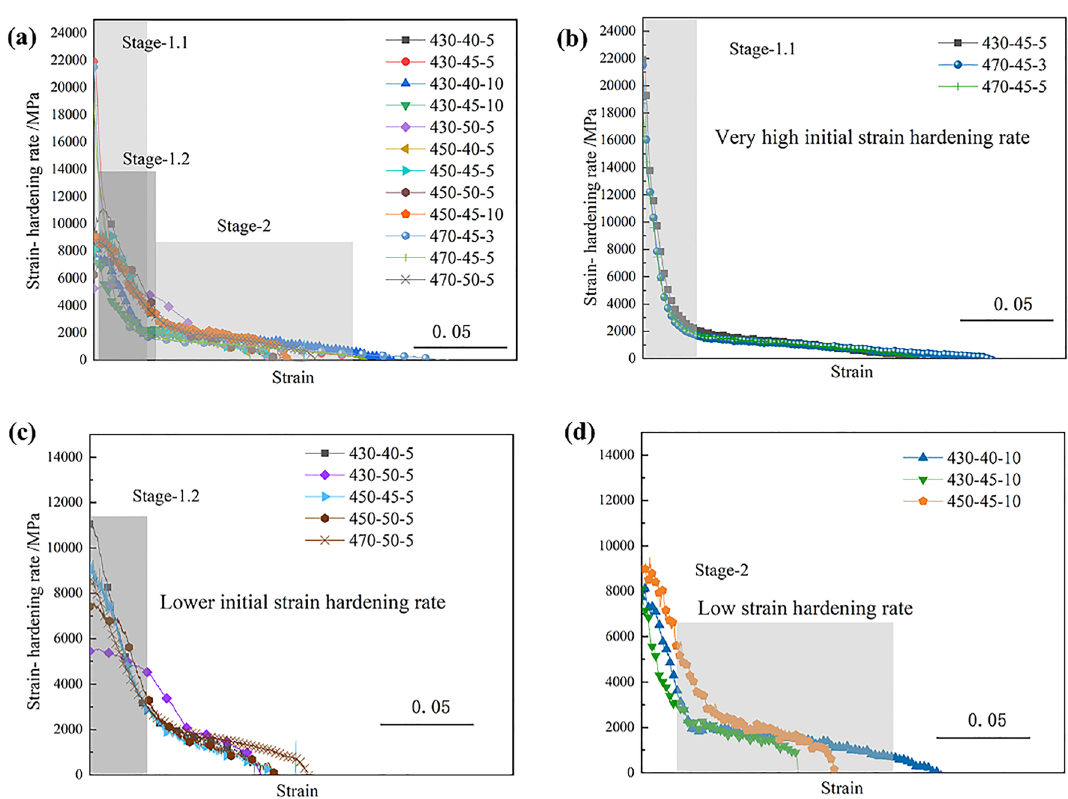
Figure 10. Strain hardening rate vs. true strain at different sintering processes: ( a) all strain hardening rate curves; ( b) the first kind; ( c) the second kind; ( d) the third kind hardening